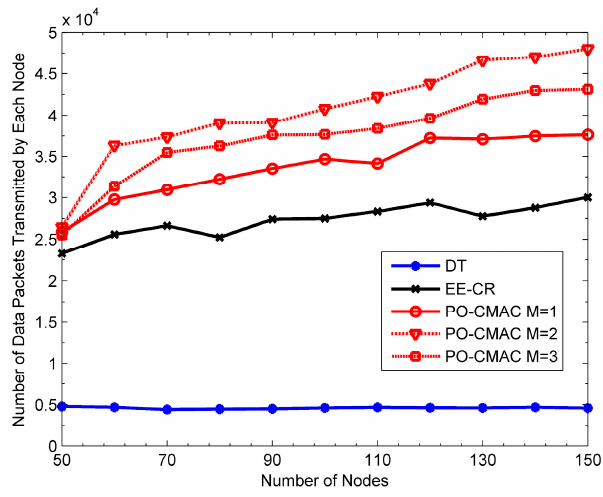
Figure 12. Network lifetime with varying N at nonuniform traffic load.